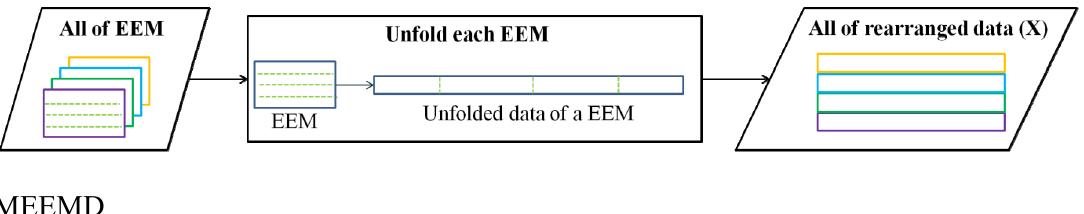
Figure 5. Rearranging procedure of the dataset.